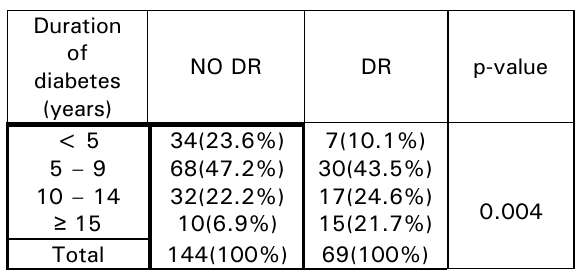
Table 4: Association of DR with duration of